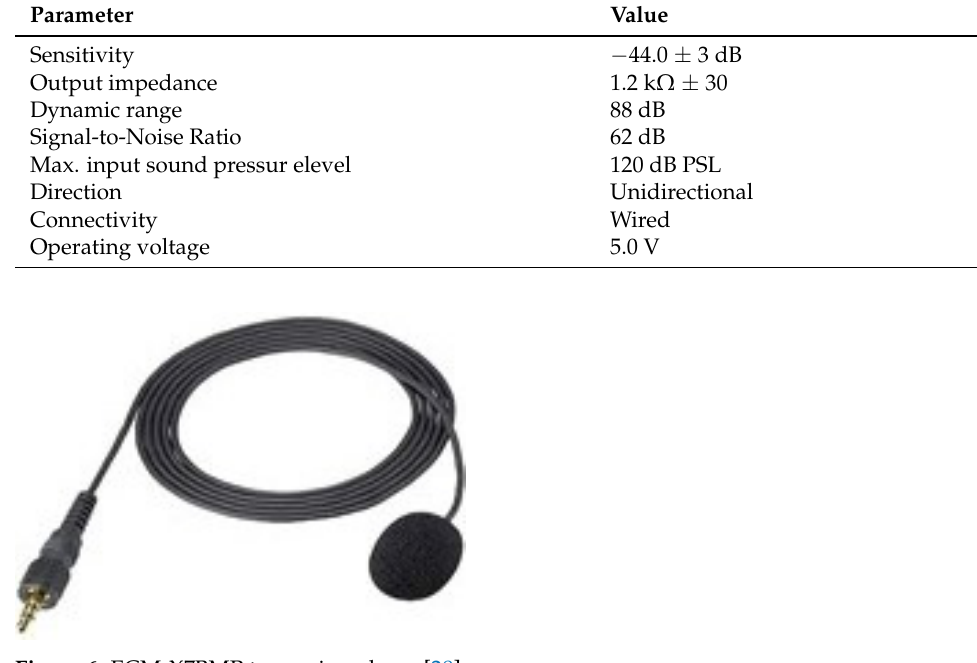
Figure 6. ECM-X7BMP type microphone [28].